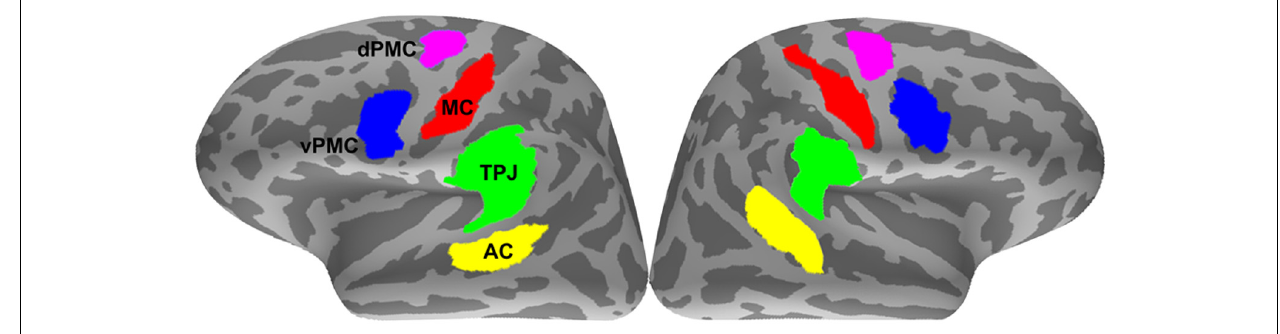
FIGURE 2 | Regions-of-interest (ROIs). AC, auditory cortex;TPJ, temporoparietal junction; MC, motor cortex; vPMC, ventral premotor cortex; dPMC, dorsal premotor